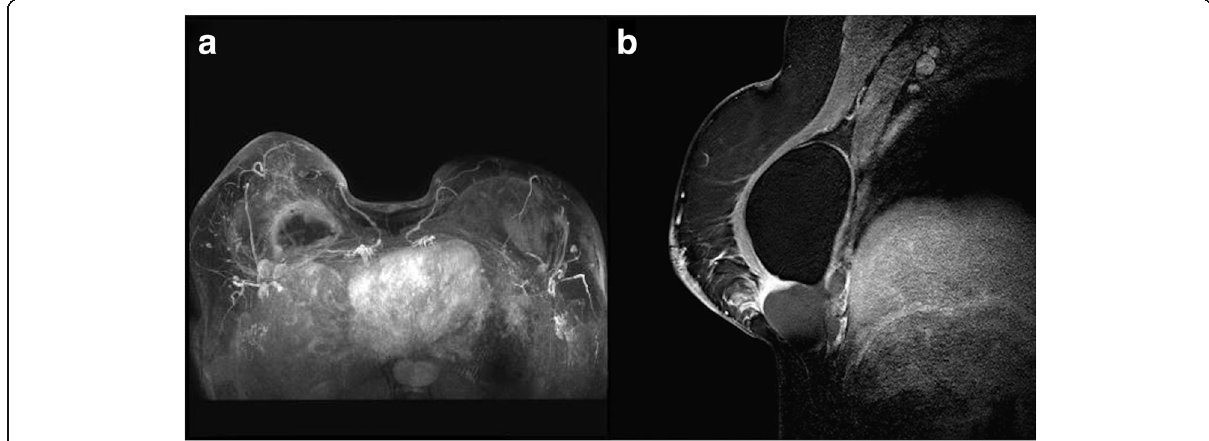
Fig. 1 Magnetic resonance imaging showing a mass in the lower inner quadrant of the right breast with rim contrast-enhancement abutting the implant surface. a Sagittal fat suppressed contrast-enhanced T1-weighted image. b Maximum intensity projection